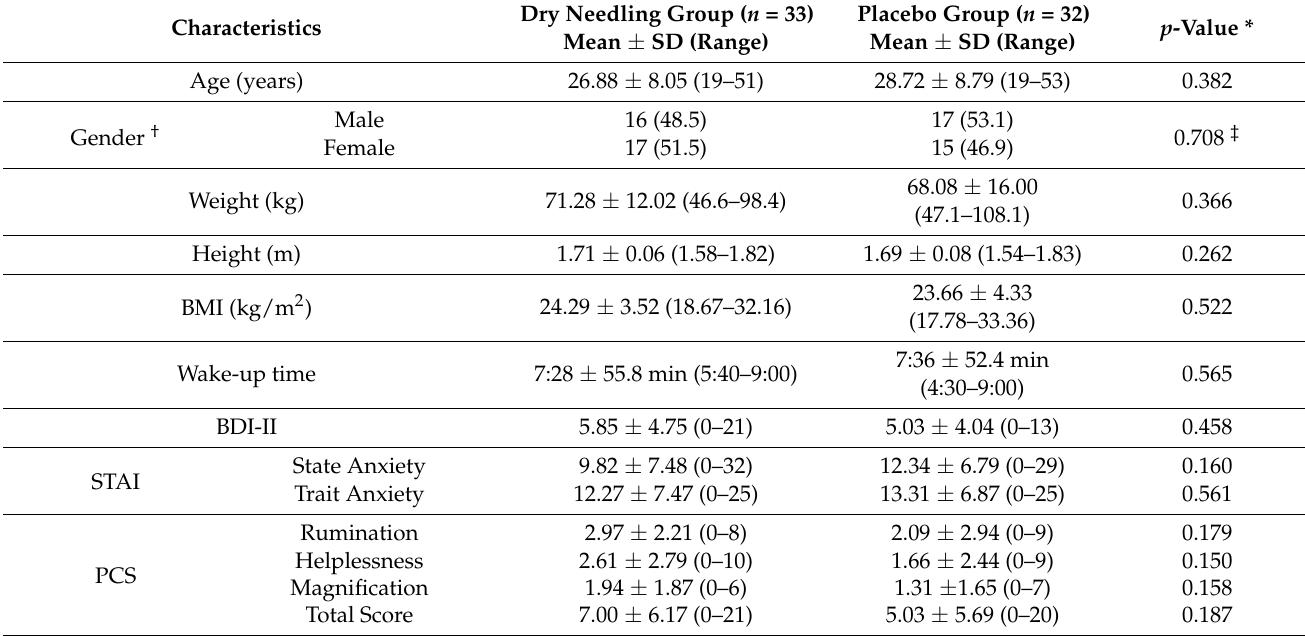
Table 1. Demographic characteristics of each treatment